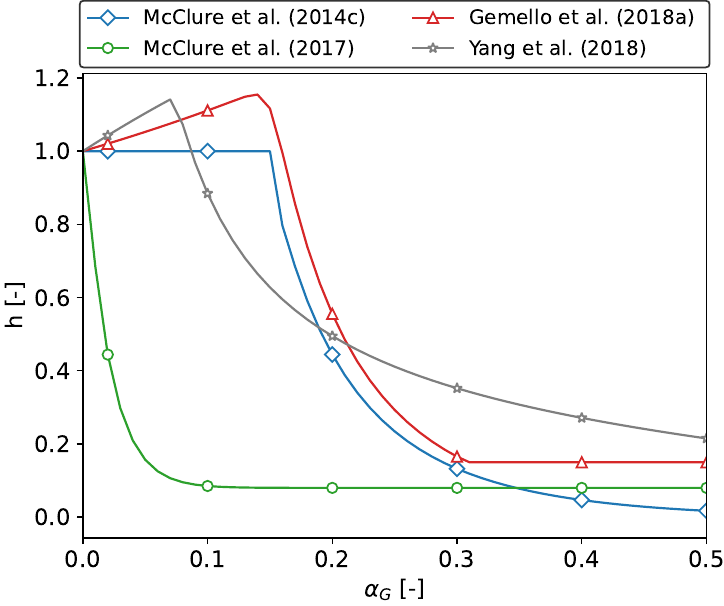
Figure 8. Drag correction factors that reduce the drag force in bubble swarms for bubbles with d b of 6.5 mm. Comparison between the correlations of McClure et al. (2014c) [28], McClure et al. (2017) [29], Gemello et al. (2018) [30] and Yang et al.